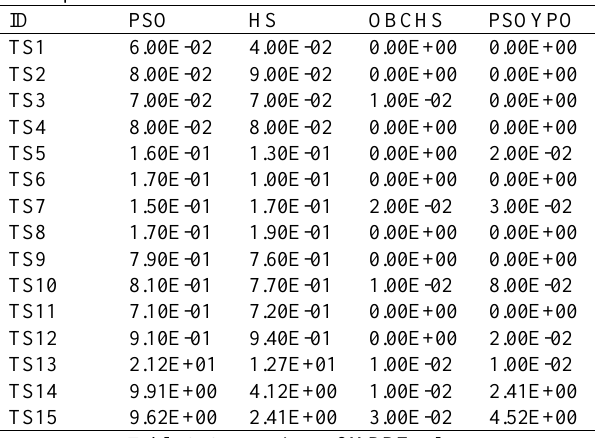
Table 2. Comparison of MRPE values